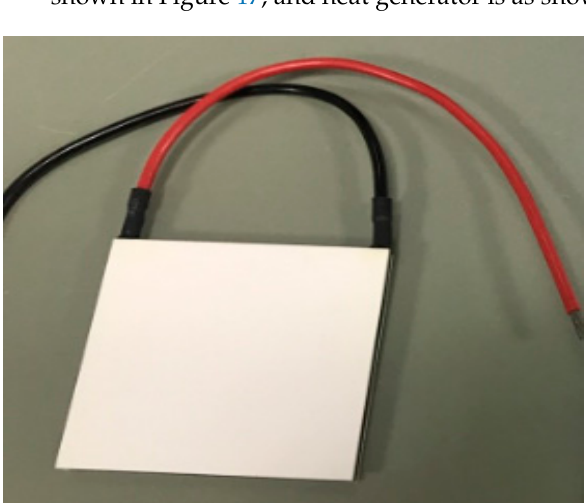
Figure 17. A thermoelectric cooling chip (TEC).